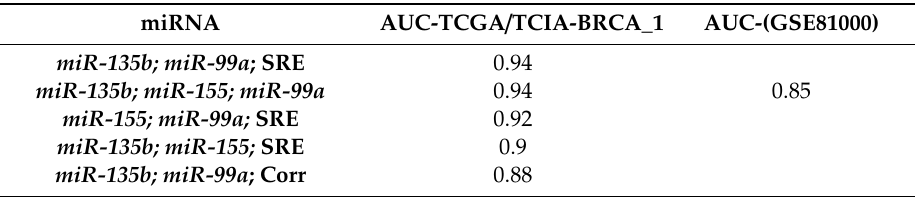
Table 4. Results of the classification using combinations of three features (miRNA / imaging features) in TCGA / TCIA-BRCA_1 and miRNAs in GSE81000.